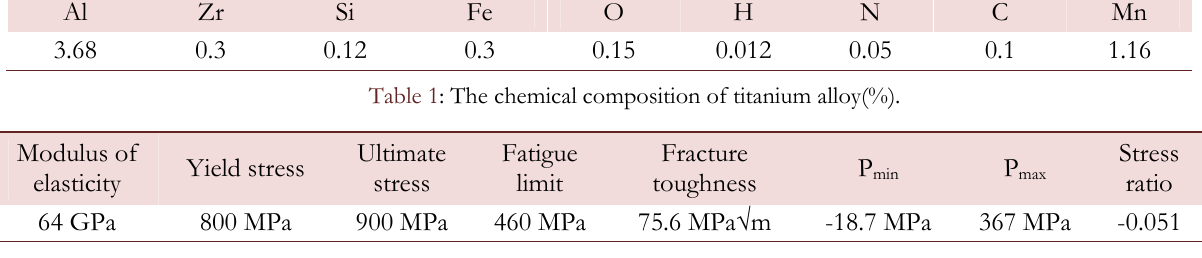
Table 2: The mechanical properties of Ti-4.2Al-1.6Mn and fatigue loading